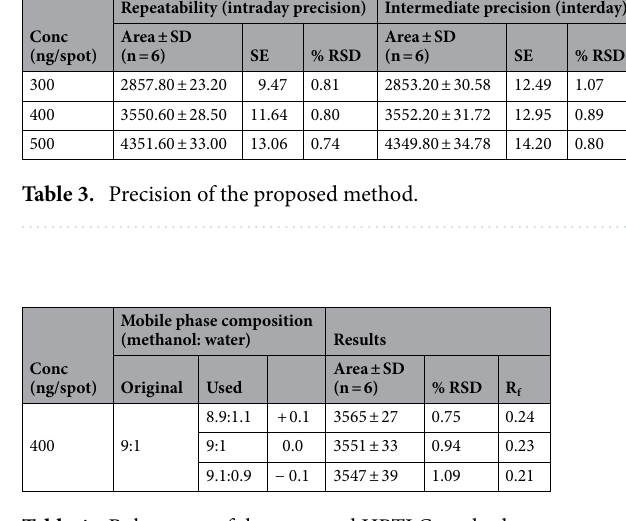
Table 4. Robustness of the proposed HPTLC method.